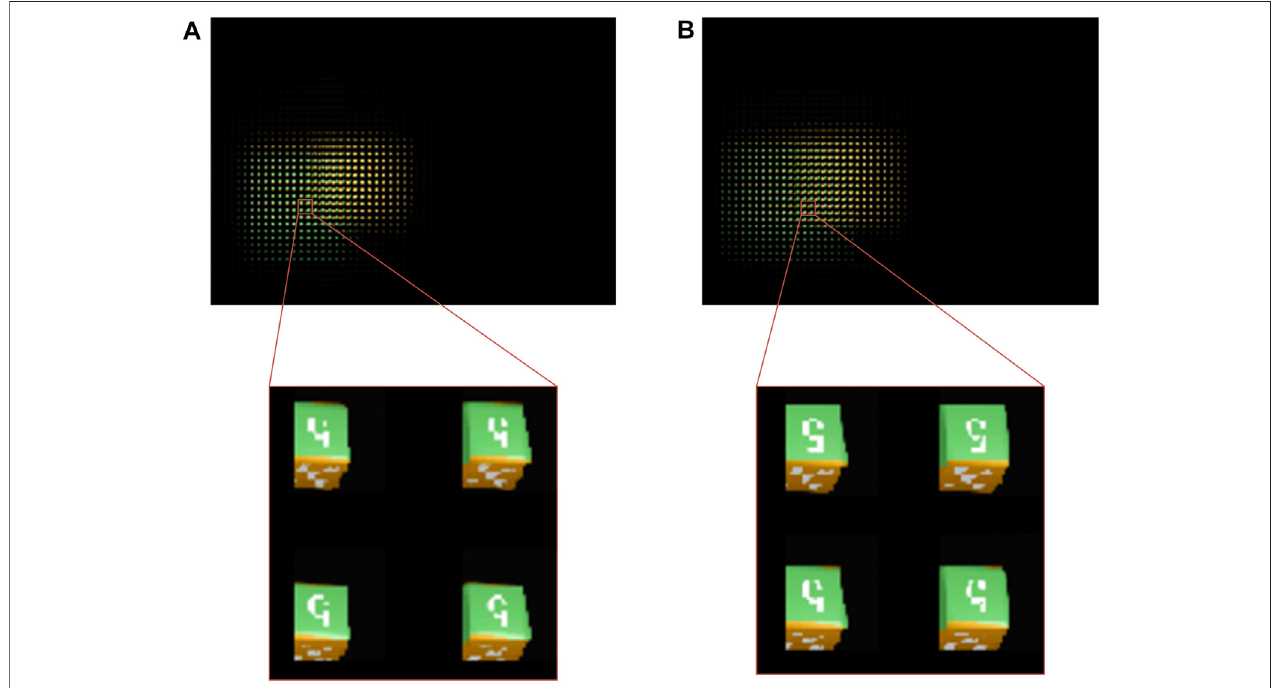
FIGURE 6 | Overall and partial magni fi cation effects: (A) SPOC algorithm and (B) SPOC1 algorithm.